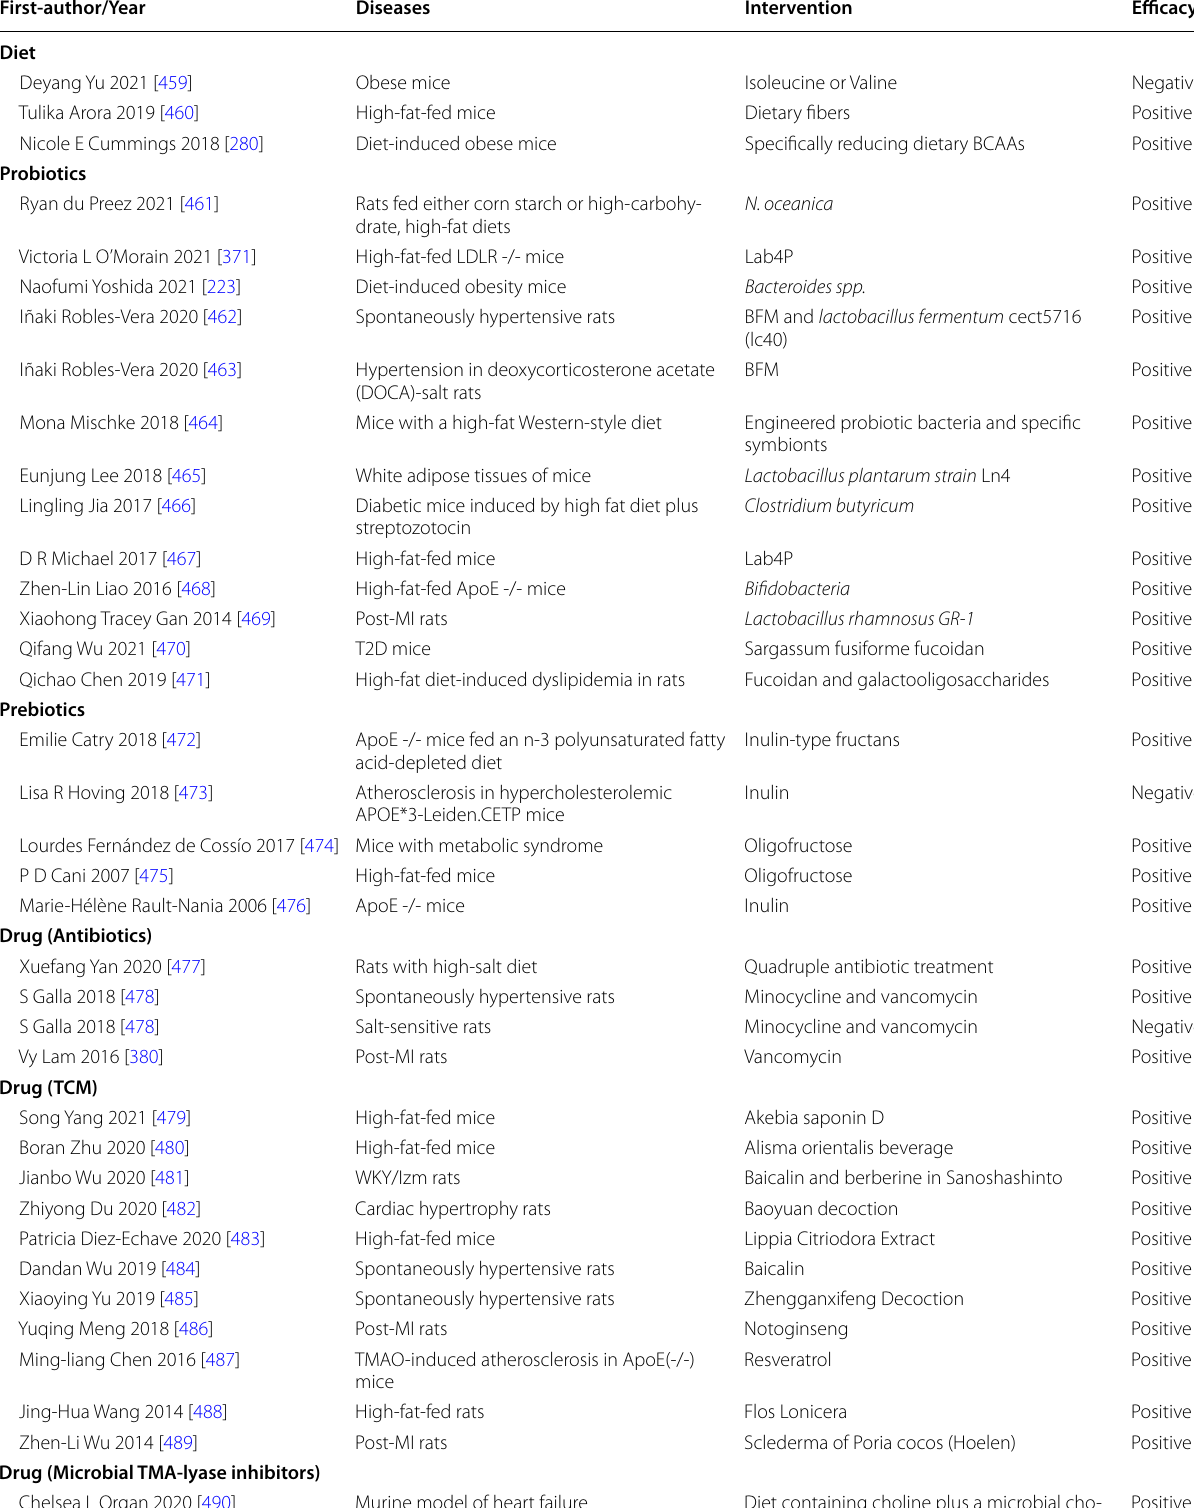
Table 2 Basic researches of targeting gut microbiota in the treatment of cardiovascular diseases